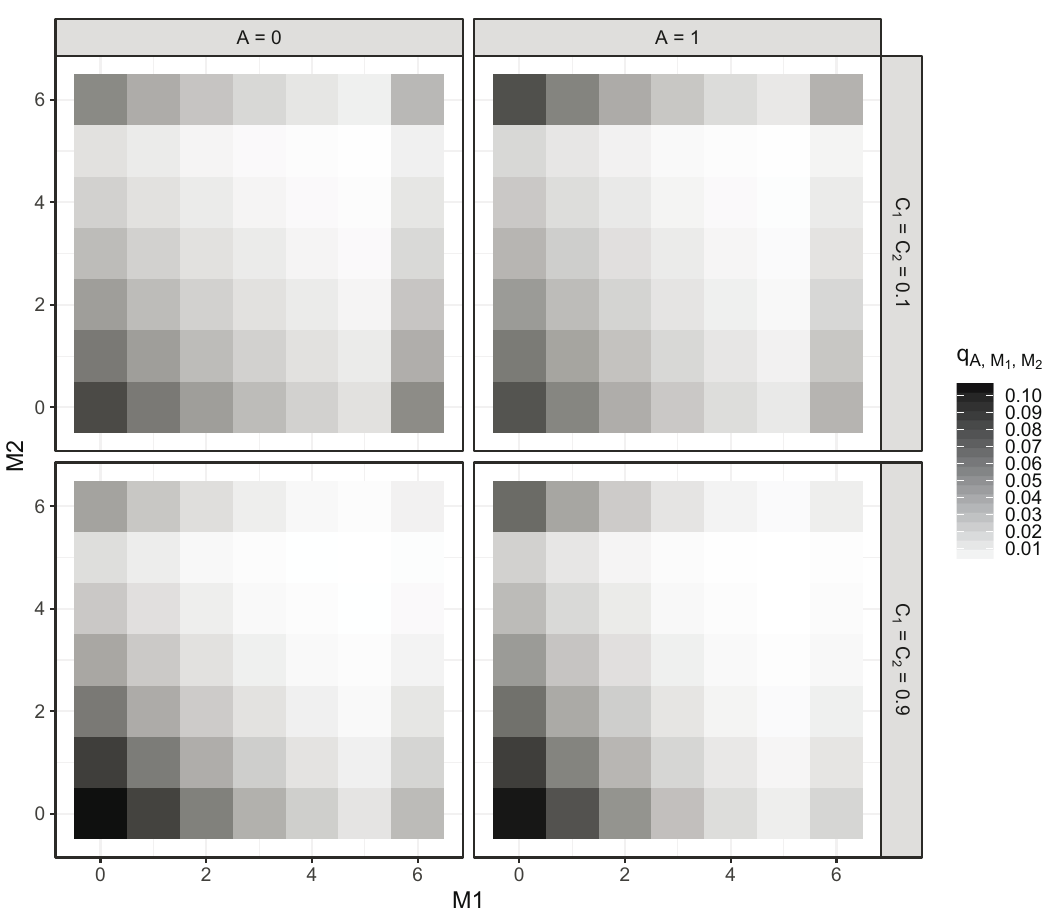
Figure 1: Joint distribution of mediators used in the